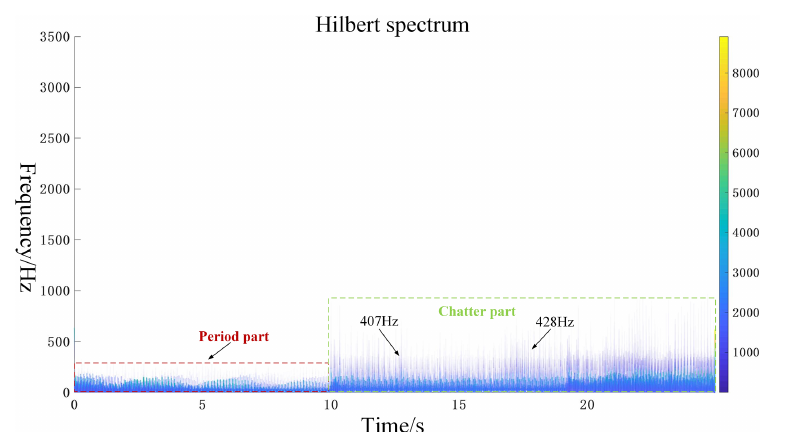
Figure 10. Time–frequency analysis of the a 4 frequency